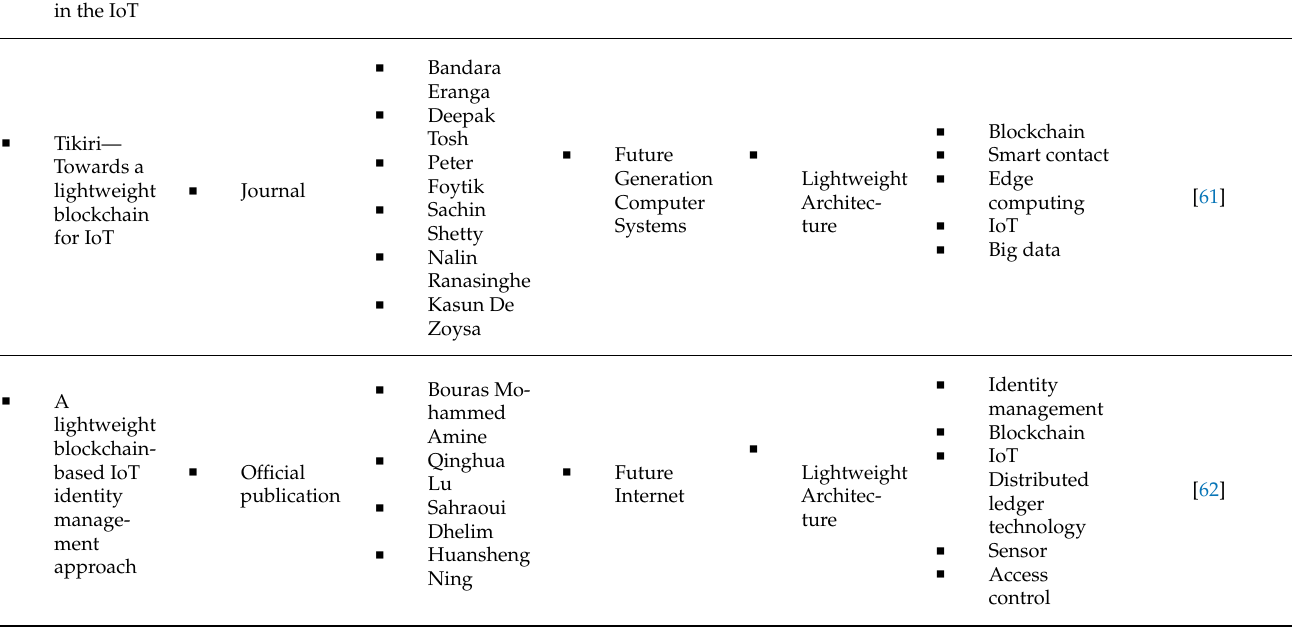
Table 3. Selected Articles.